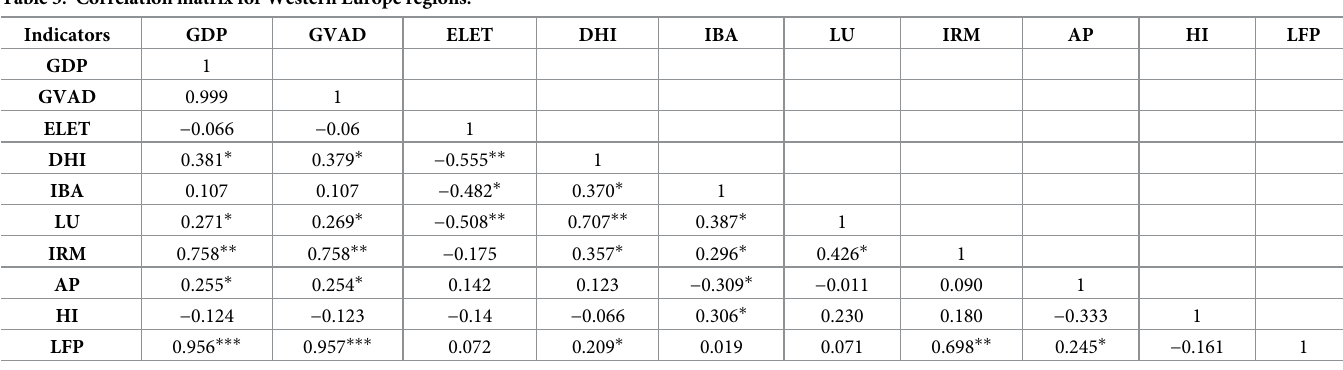
Table 5. Correlation matrix for Western Europe regions.